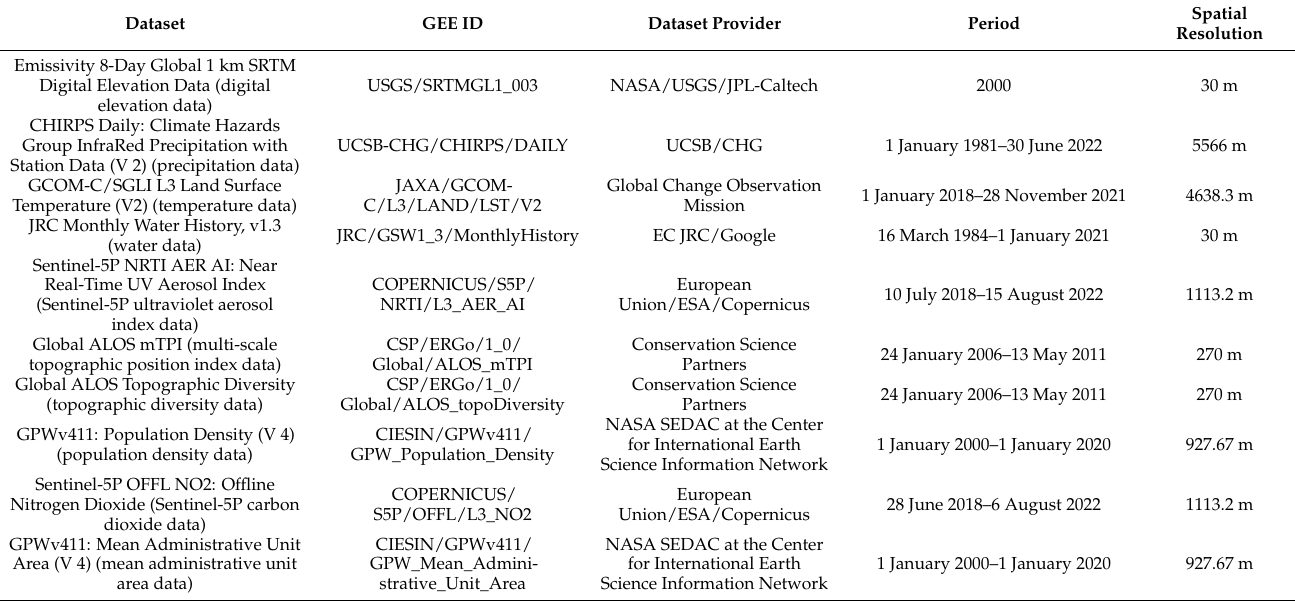
Table 1. The auxiliary data used in this